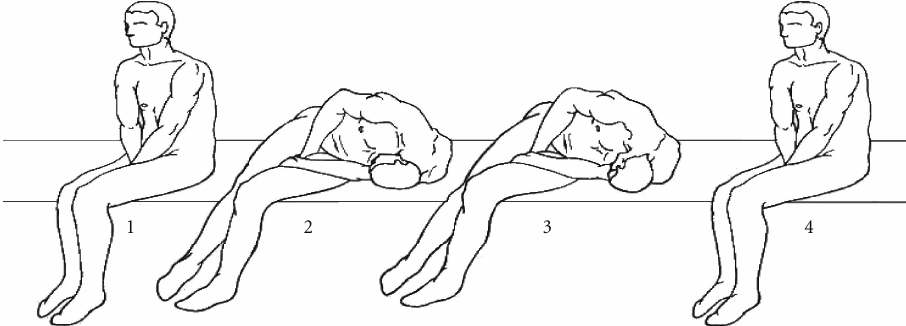
Figure 1: Gufoni’s manoeuvre for the geotropic form of right HSC-BPPV [11].